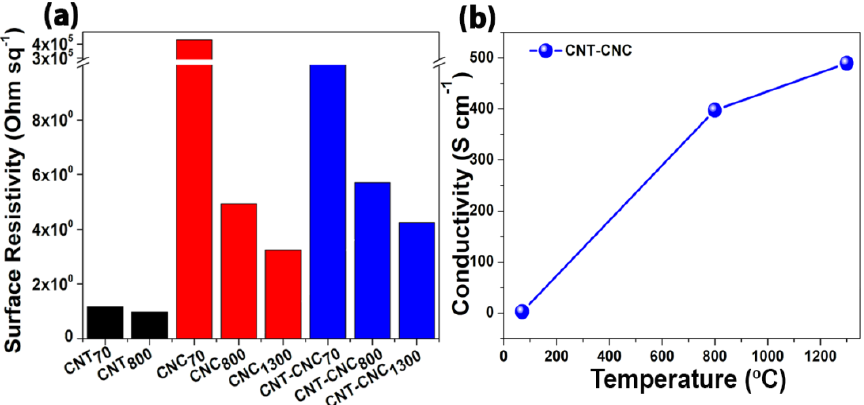
Figure 6. ( a ) Surface resistivity of various samples. ( b ) Conductivity of CNT – CNCs with different annealing temperatures.